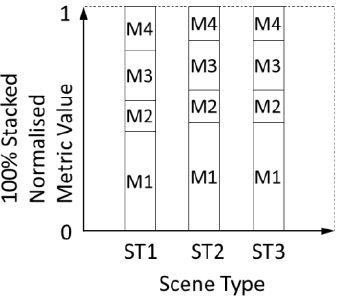
Figure 7 Metric spectrum for different scene